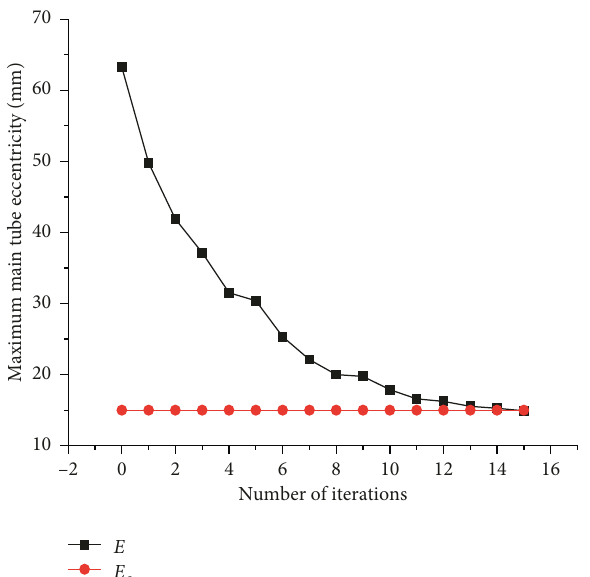
Figure 7: Maximum main tube